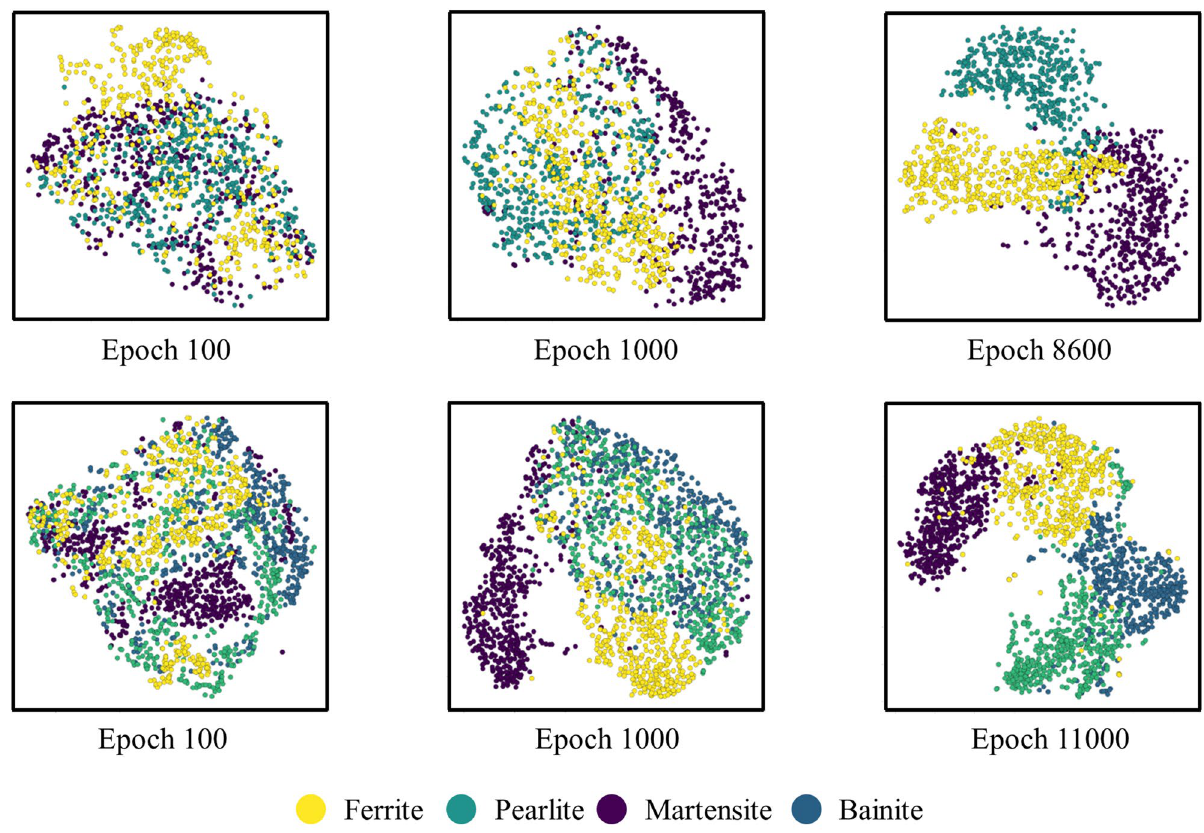
Figure 9. t-SNE visualization of generated features at different epochs. The top row represents the embedded feature distributions for Steel E while the bottom row does it for Steel